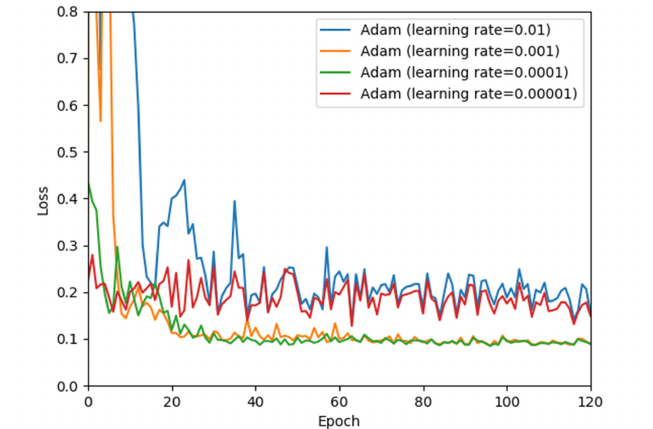
Figure 8. Different learning rate of Adam algorithm on validation